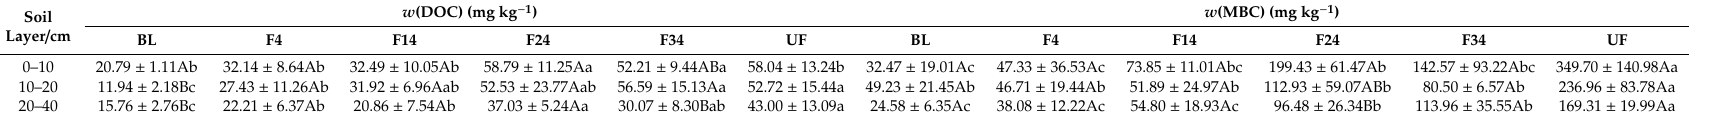
Table 4. Vertical distribution of w (DOC) and w (MBC) in the di ff erent forest sites.